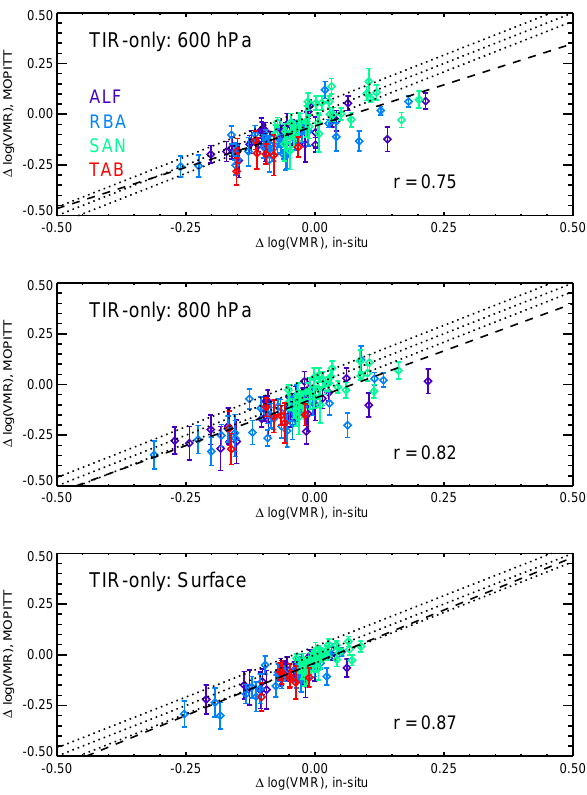
Figure 7. MOPITT Version 6 TIR-NIR validation results (as pre- sented in Fig. 5), with a priori influence removed from both the MO- PITT retrieved values and simulated retrievals based on the in situ data. As discussed in Sect. 3.2.3, plotted values correspond to the difference of retrieved (or simulated) log(VMR) values and the a priori log(VMR)